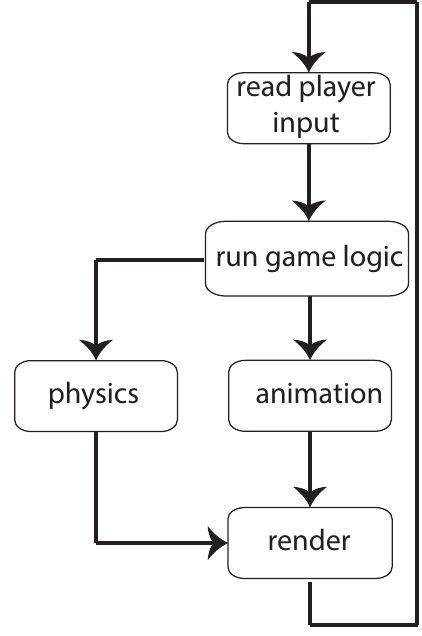
Figure 5. Synchronous Function Parallel Model.